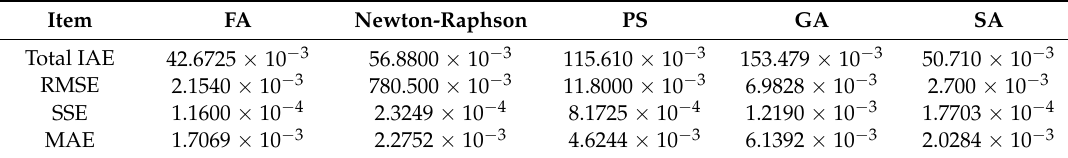
Table 14. Comparison of performance indexes for photovoltaic module Photowatt-PWP 201.